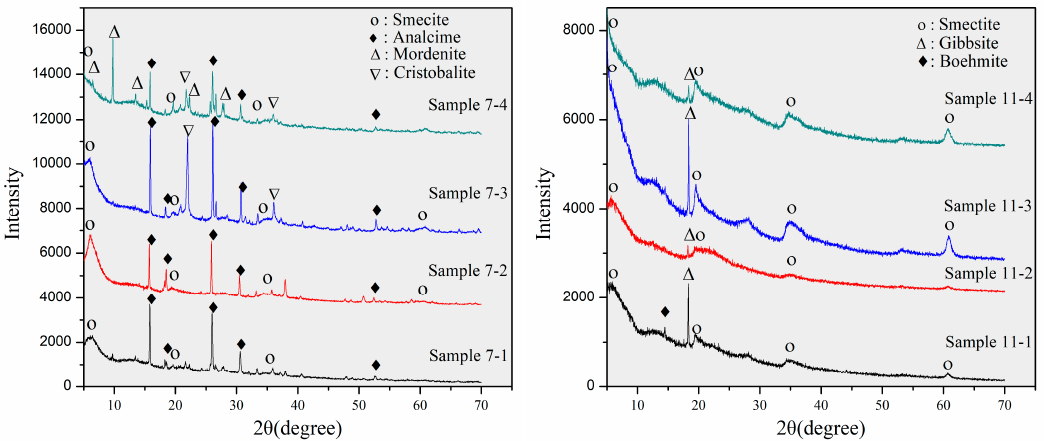
Figure 2. XRD analysis indicating numerous impurities in the products of experiments 7 and 11 in the L18 array.